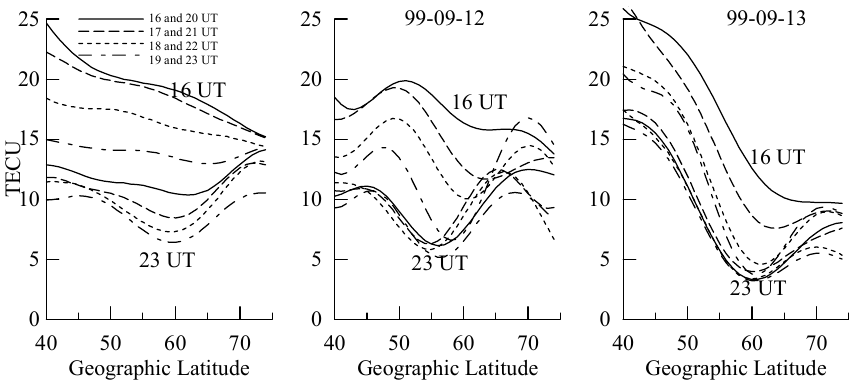
Fig. 10. The dynamics of latitude pro- files at post-noon sector for quiet day (11 September – left panel) and dis- turbed